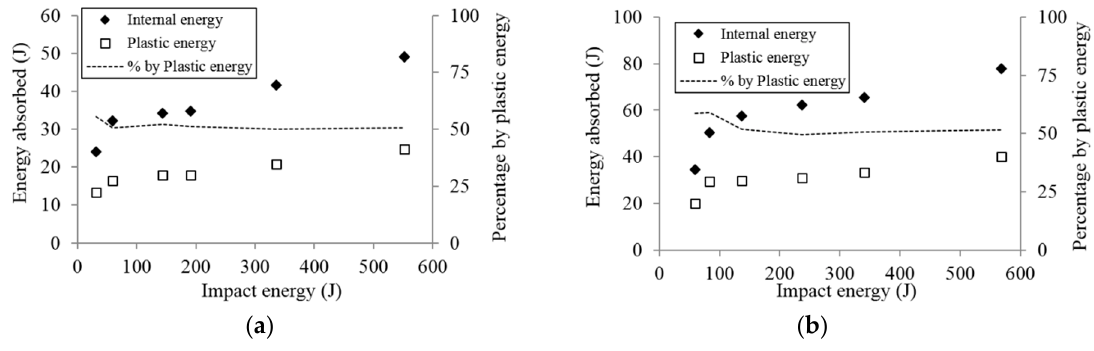
Figure 7. Energy absorption by the TFML panels at different impact energy. ( a ) TFML-2/1; ( b ) TFML-3/2.